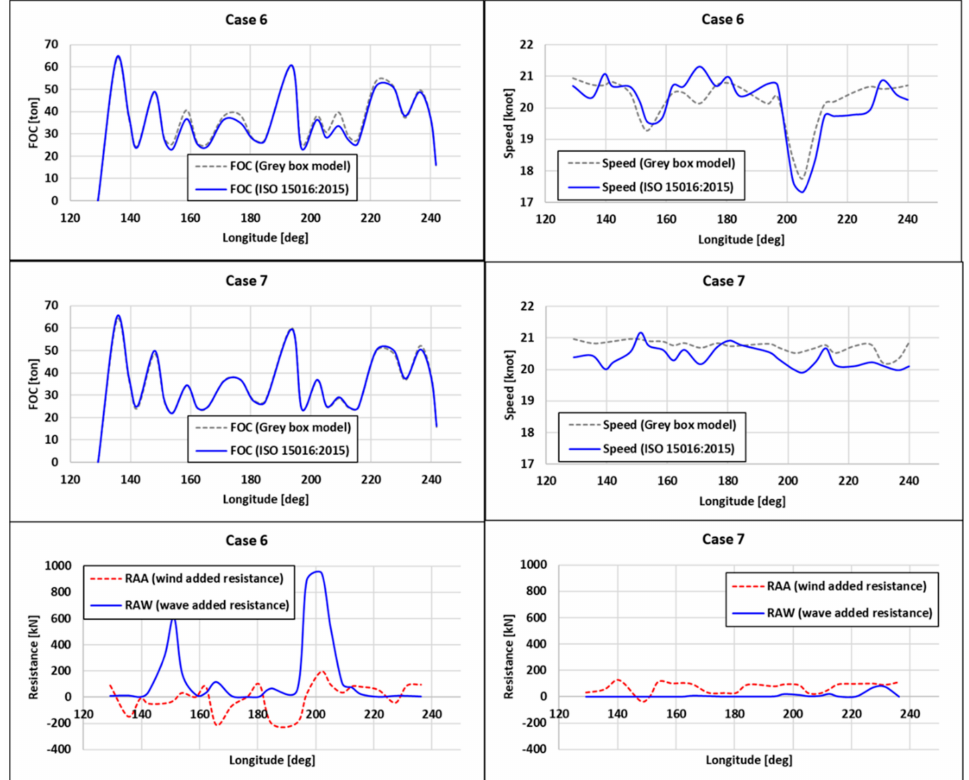
Figure 13. FOC, speed, and additional resistance graphs of Cases 6 and